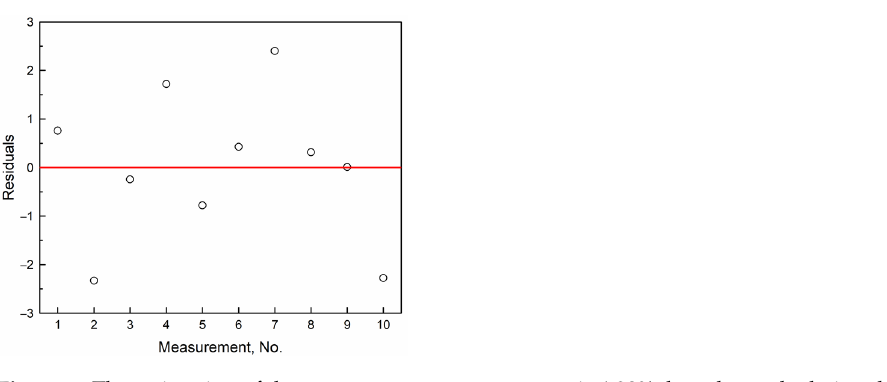
Figure 3. The estimation of the contrast measurement error is 4.98%, based on calculating the relative standard deviation after numerous repetitions of a single loading–unloading cycle.